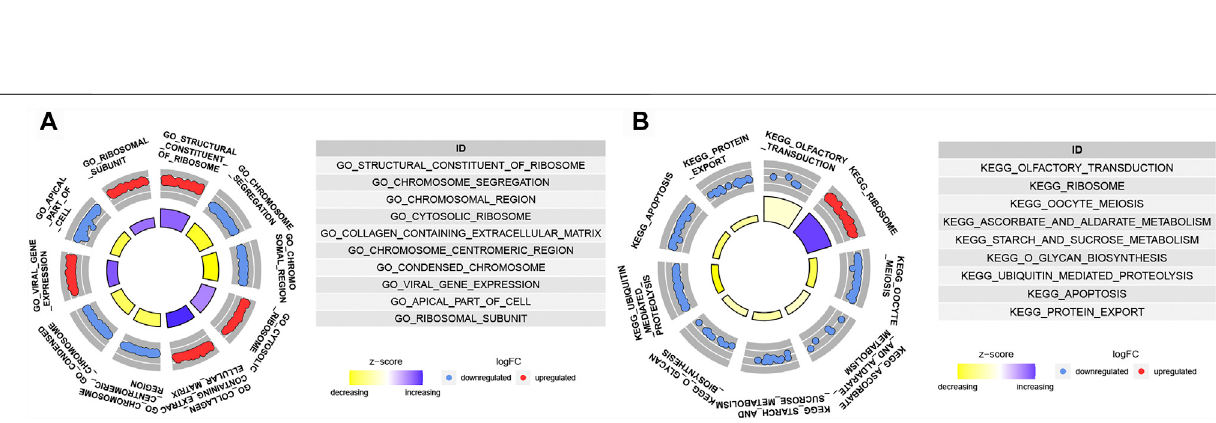
Frontiers in Genetics |